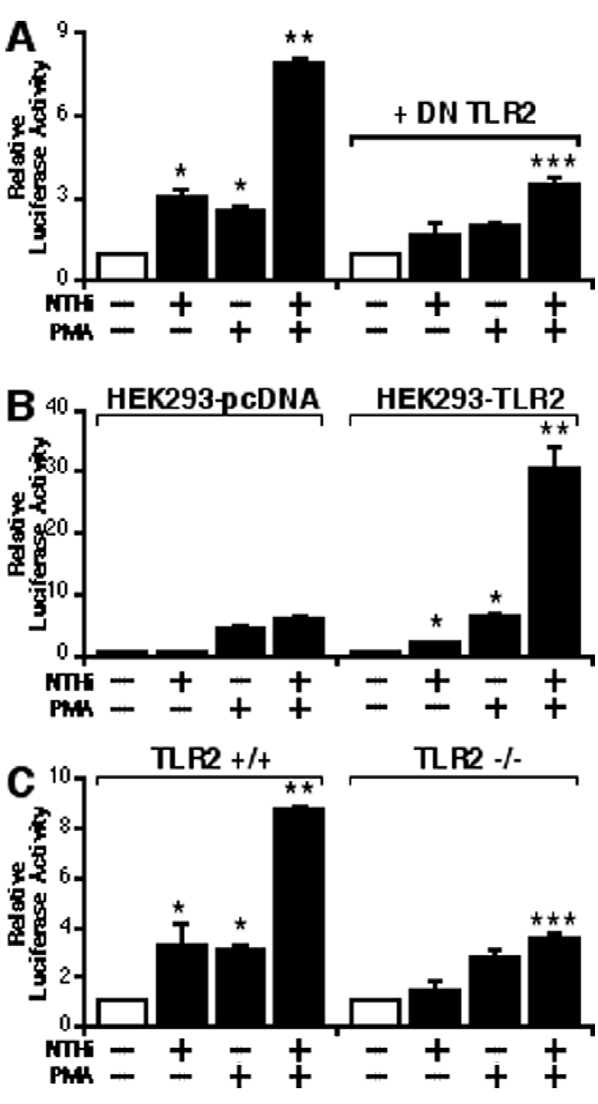
Figure 3. TLR2 is involved in the synergistic enhancement of NTHi-induced MUC5AC expression by PMA. (A) Overexpression of a DN mutant form of TLR2 inhibited the synergistic induction of MUC5AC transcription by NTHi and PMA in human epithelial cells, as assessed by MUC5AC-dependent promoter Luciferase assay. Cells were transfected with 0.8 m g of DN TLR2 or control vector, and treated with NTHi with or without PMA. Relative luciferase activity of MUC5AC was measured from the cell lysate. ( B ) The synergistic enhancement of NTHi- induced MUC5AC transcription by PMA was observed in HEK293-TLR2 cells, but not in HEK293-pcDNA cells. ( C ) PMA did not synergize with NTHi to induce MUC5AC expression in TLR2 2 / 2 MEF cells. Values are the means 6 S.D. (n=3). *p , 0.05 vs. control; **p , 0.05 vs. NTHi alone; ***p , 0.05 vs NTHi with PMA in control vector transfected cells ( A ) or TLR2 + / + cells ( C ). The data shown are representative of three independent experiments. 2 , absence of; + , presence of; NTHi, nontypeable Haemophilus influenzae ; DN, dominant negative; + / + , wild-type; 2 / 2 , knock-out.